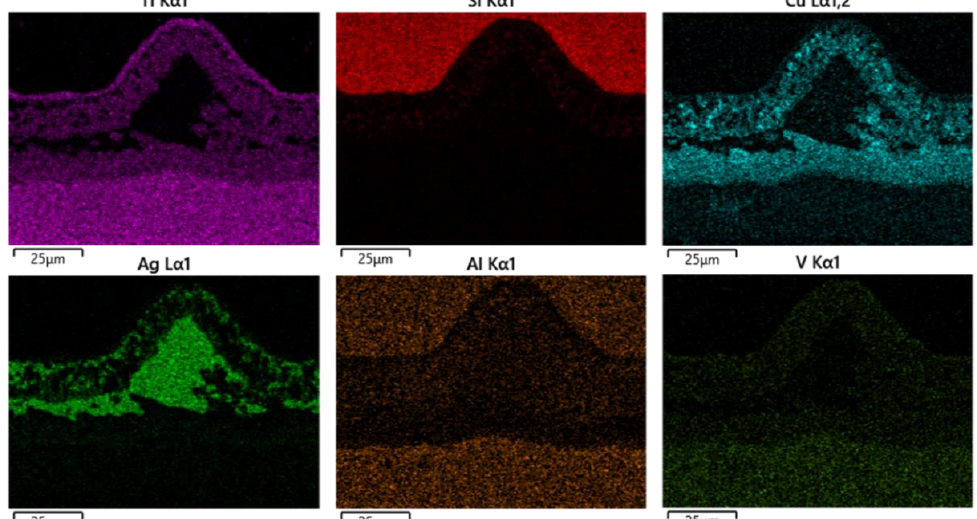
Figure 6. Elemental mapping of Si 3 N 4 –titanium alloy joint with a loose